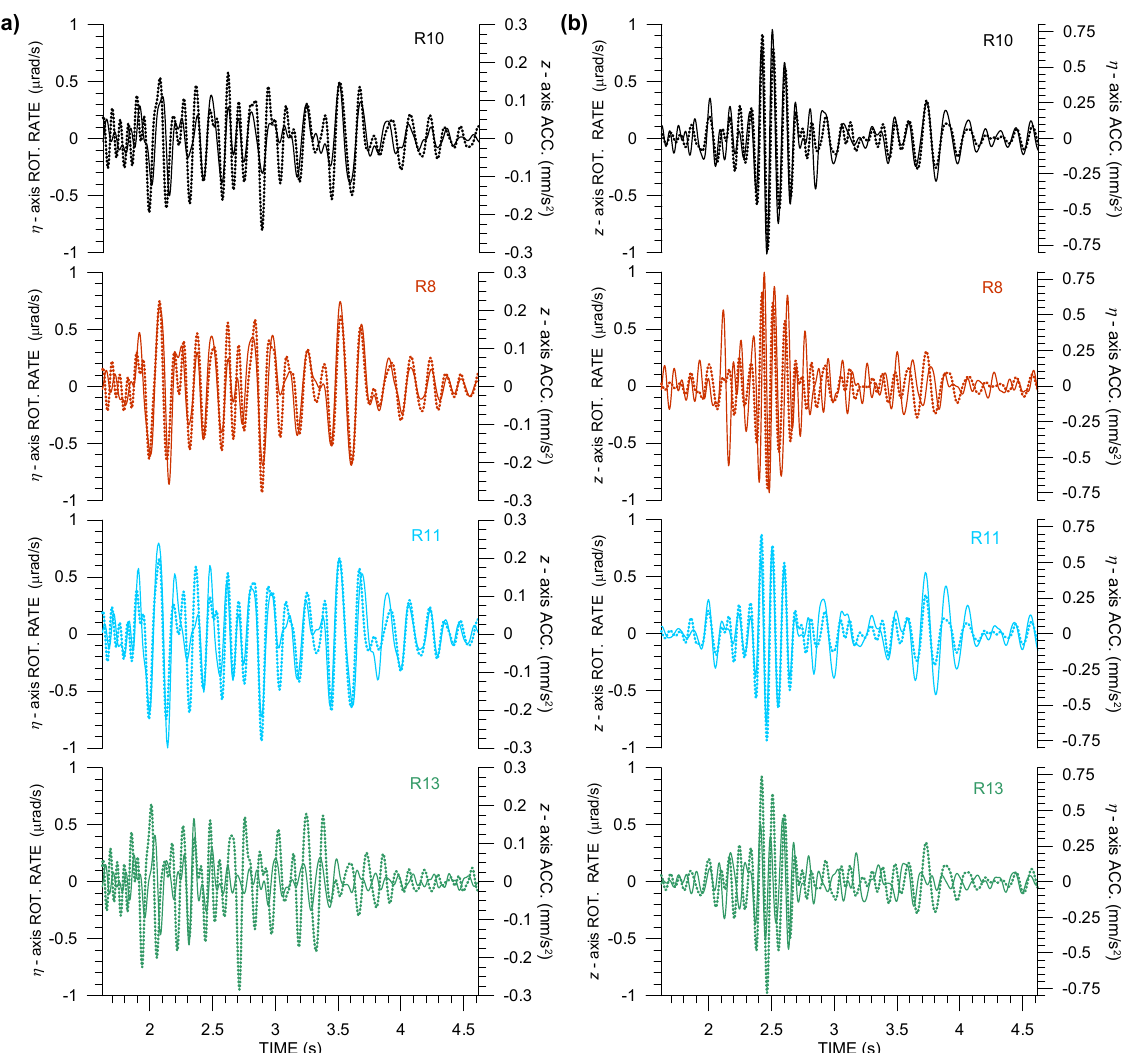
Figure 11. Waveform matching of the relevant rotation rate (solid) and ground acceleration (dotted) components in records of Expl5 in the active part of the GOF experiment from four 6C Rotaphone-CY instruments (R8—red, R10—black, R11—light blue, and R13—green): rotation rates that are around the transverse axis and vertical ground acceleration ( a ), and rotation rates around the vertical axis and transverse ground acceleration ( b ). The transverse axis is perpendicular to the geometrical azimuth of 285.0 ◦